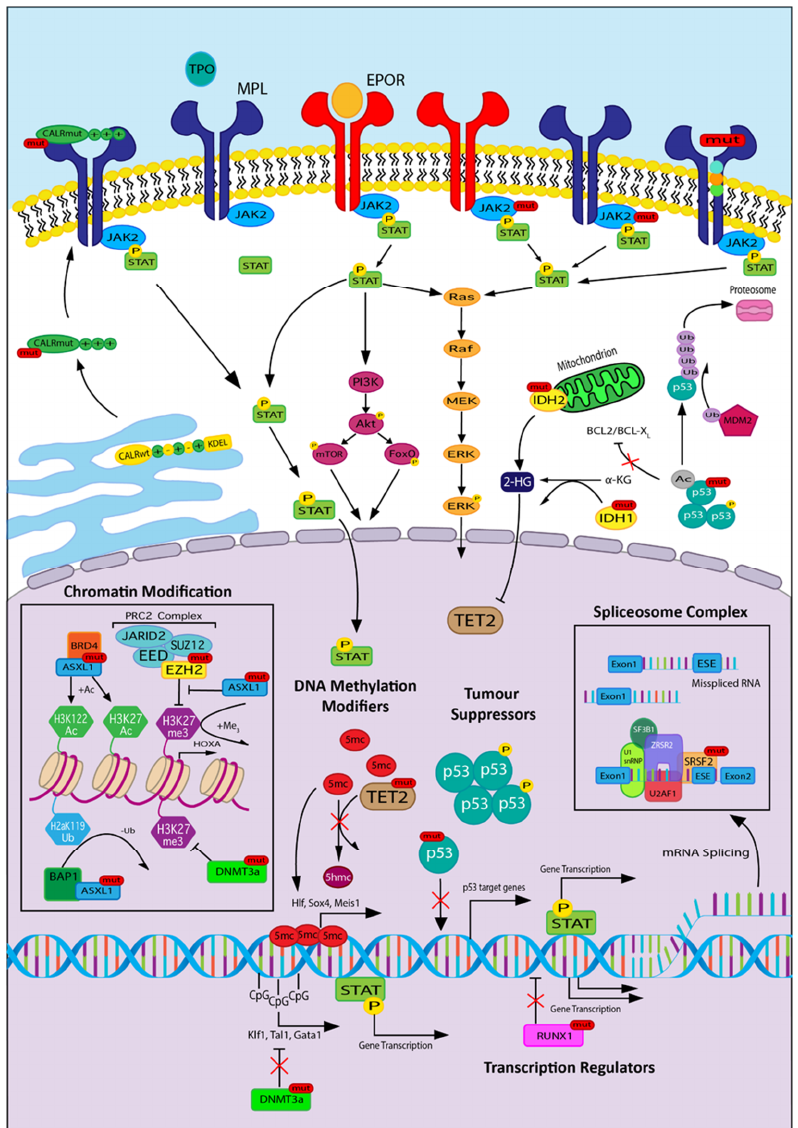
Figure 2. The molecular signalling pathways involved in MPN: The cell surface receptors are erythropoietin receptor (EPOR; red) and thrombopoietin receptor/MPL (navy blue), MPL with mutated Calreticulin (CALR), wildtype MPL with no ligand (thrombopoietin (TPO)) bound and no STAT signalling, wildtype EPOR with bound ligand (erythropoietin (EPO)) leading to STAT signalling, EPOR with JAK2 mutant, MPL with JAK2 mutant and mutated MPL. The cytoplasm shows STAT pathway signalling with activation of phosphatidylinositol 3-kinase (PI3K)/Akt and RAS pathways, and the nucleus (lilac background) shows the effects of driver and coexisting mutations on nuclear functions. Headings for DNA methylation modifiers, tumour suppressors, transcription regulators, spliceosome complex and chromatin modification identify the key sites of coexisting mutations. Abbreviations not mentioned in the body of the article: STAT, signal transducers and activators of transcription; PI3K, phosphatidylinositol 3-kinase; Akt, Protein kinase B; mTOR, mammalian target of rapamycin; SUZ12, suppressor of zeste 12 homolog; EEZ, embryonic ectoderm development; BAP1, BRCA1-associated protein 1; BRD4, bromodomain containing protein 4; BCL-2, B cell lymphoma 2; BCL-XL, B cell lymphoma extra large; Ac, acetylated; Me, methylated; Ub, ubiquitinated; P, phosphorylated; mut,